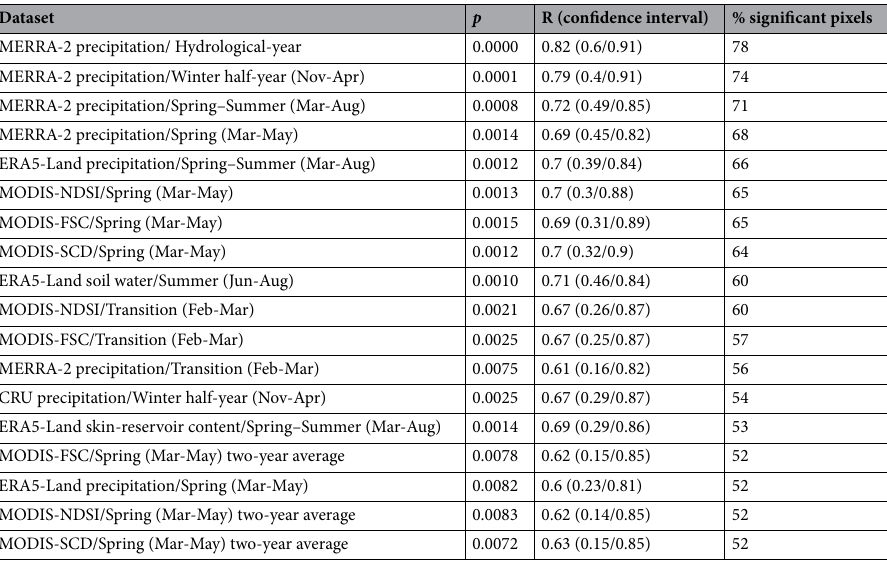
Table 1. Highly suitable variables (significant values controlled at a FDR < 5% and ≥ 50% of analyzed pixels show significant correlation) and evaluation metrics in the Wakhan study region. Descending order based on percentage of significant